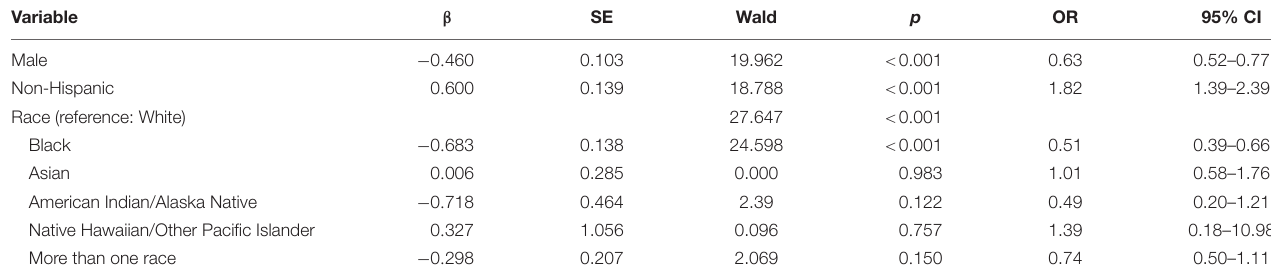
TABLE 6 | Logistic regressions for support received/sought out.